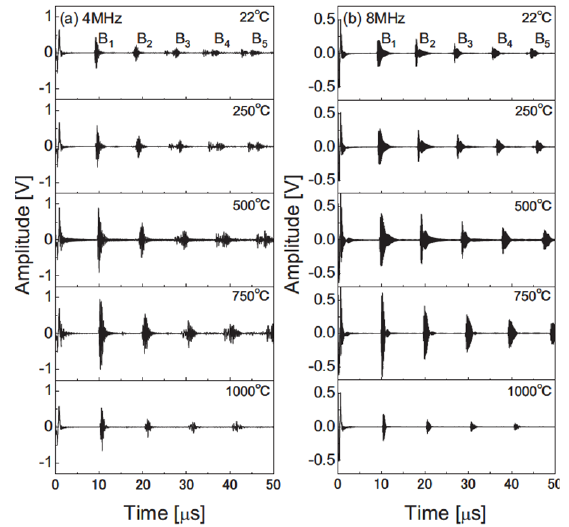
Figure 13. Measured waveforms of multiple echoes at temperatures up to 1,000 °C for ( a ) the 4 MHz transducer and ( b ) the 8 MHz transducer [84] (copyright 2010 by the American Institute of